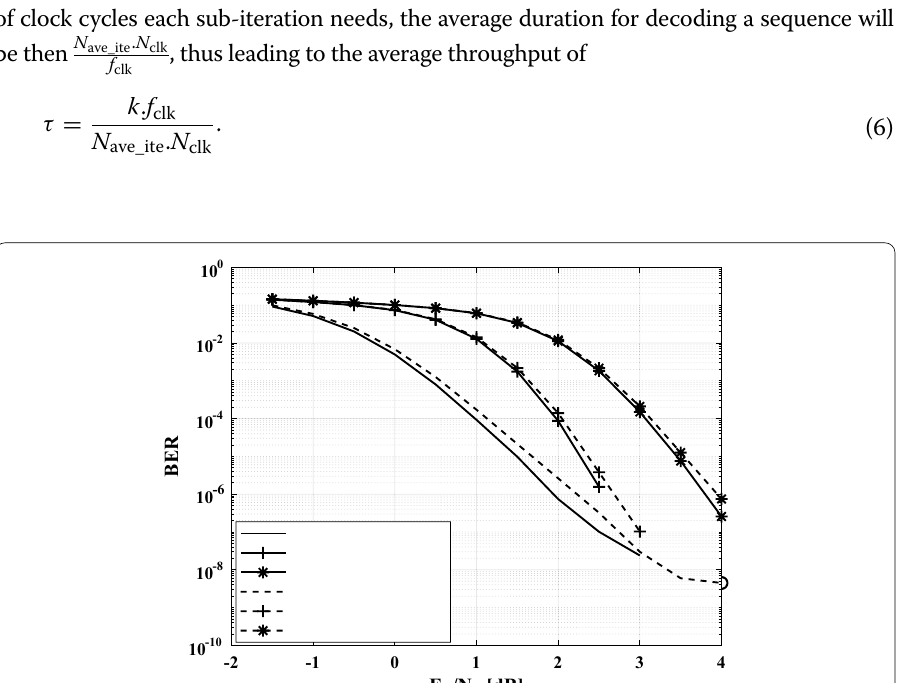
Fig. 9 BER performance for the example QC-LDPC